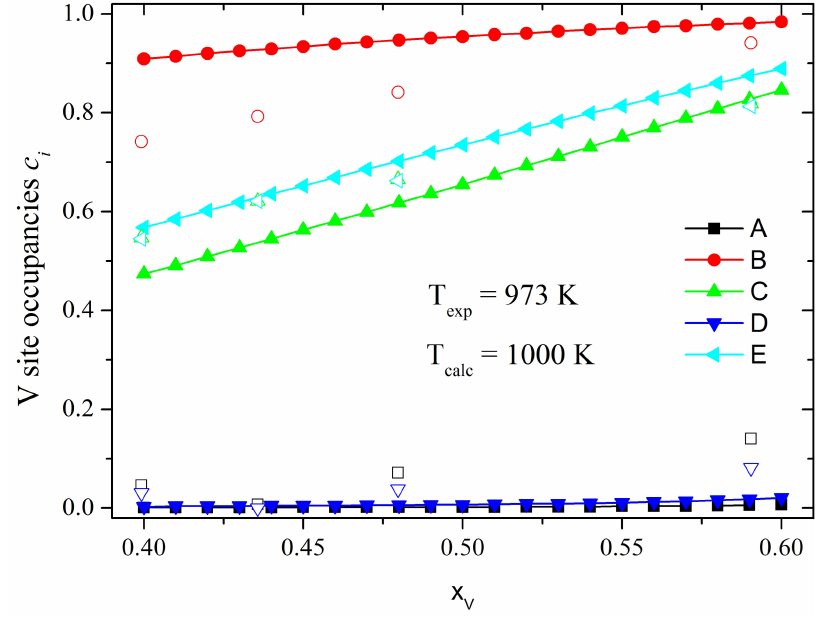
Figure 5. The V site occupancies of the (A, B, C, D, E) sublattices versus the V composition, x , at fixed T = 1,000 K. The full symbols denote the calculated results, the empty symbols V represent the available experimental data (error bars within the symbol sizes) [28,32]. J (1) and µ ( Fe,V ) are obtained for Fe V at T = 1,000 α 0 . 5 0 . 5